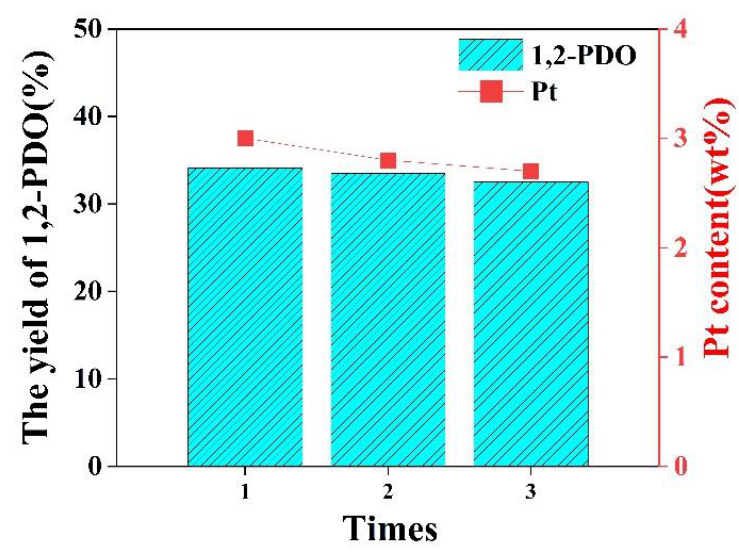
Figure 6. Reusability and metal leaching of Pt/deAl-Beta@Mg(OH) 2 .